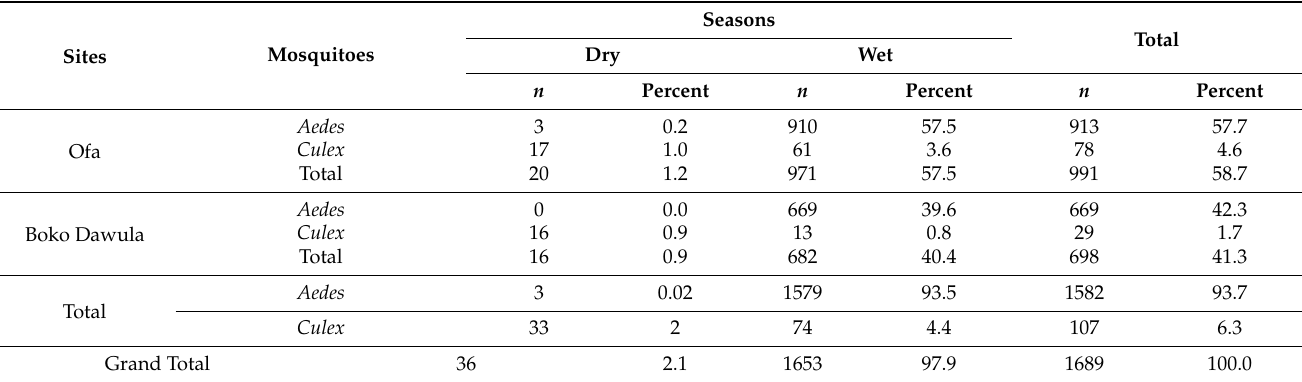
Table 1. Mosquito species composition and seasonal distribution in Ofa and Boko Dawula districts, southwestern